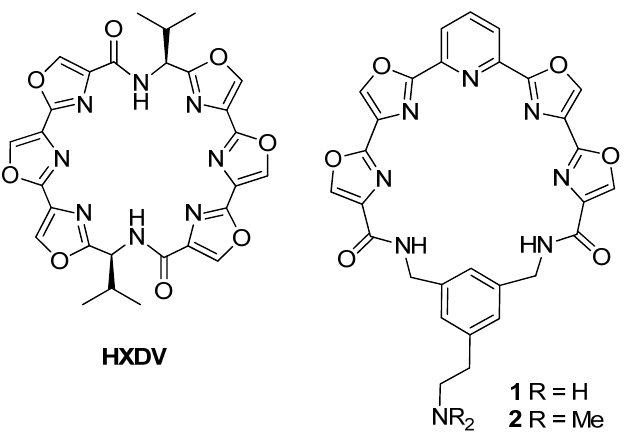
Figure 1. Structures of HXDV and pyridyl polyoxazole (PyPX) macrocycles 1 and 2